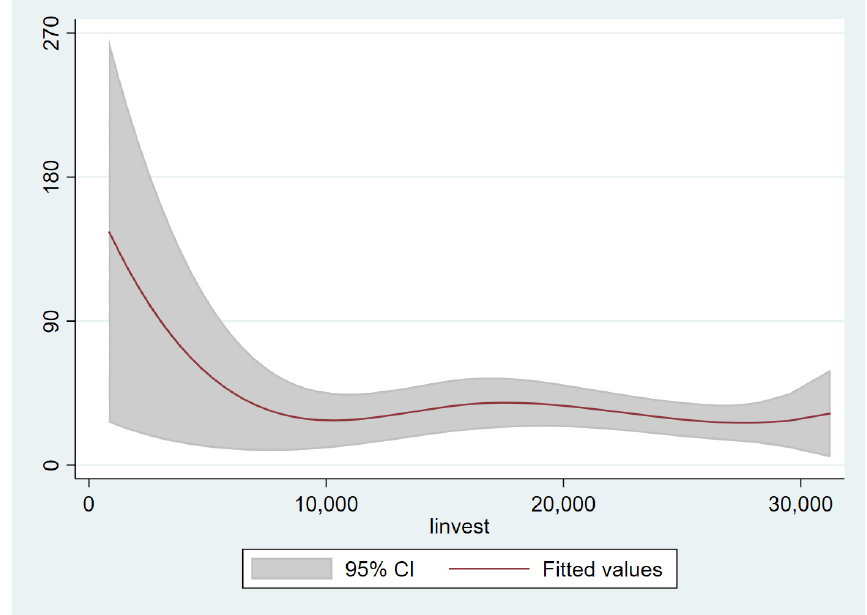
Figure 8. Partially linear functional-coefficient panel data model estimation results.